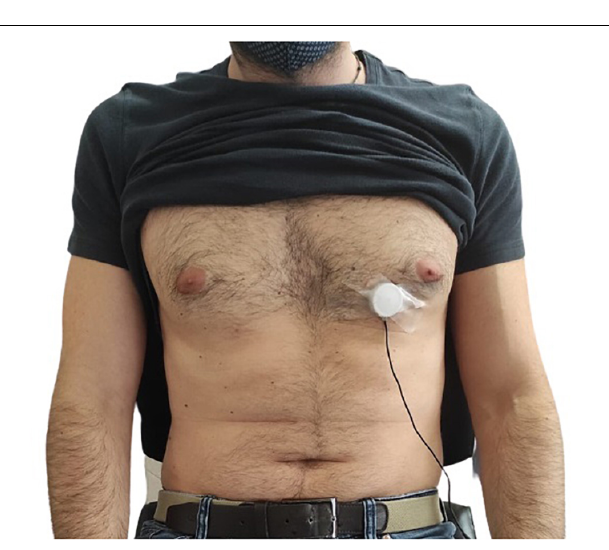
lag, which was used for time alignment; then their Pearson’s correlation coefficient was computed to evaluate their